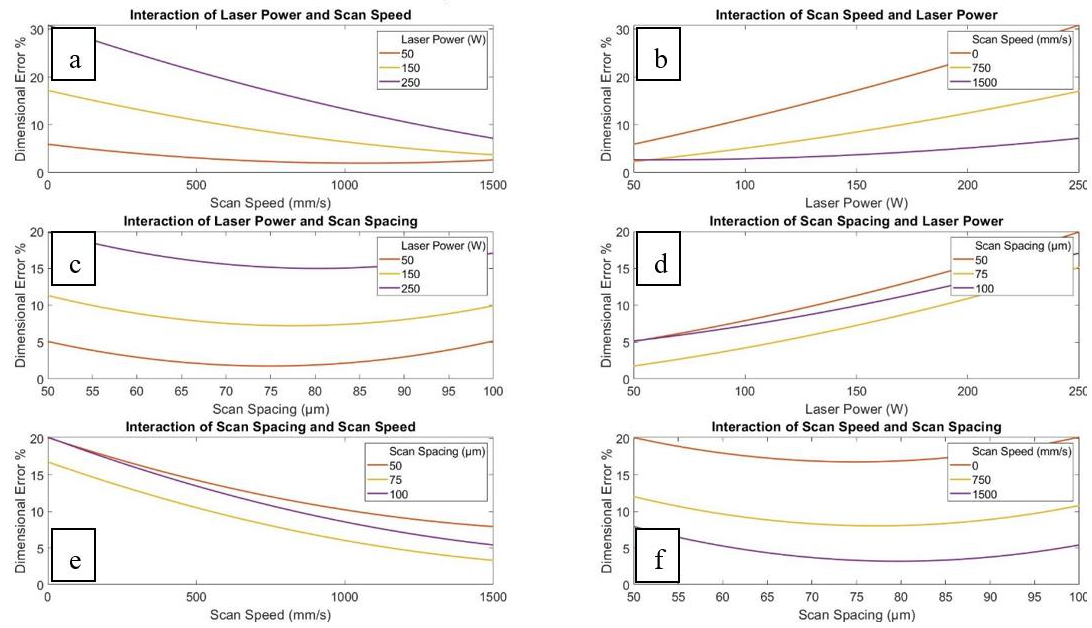
Appl. Sci. 2020 , 10 , x FOR PEER REVIEW Figure 4. Plots depicting the interaction e ff ects of the laser power, scan speed, and scan spacing. Figure 4. Plots depicting the interaction effects of the laser power, scan speed, and scan spacing.